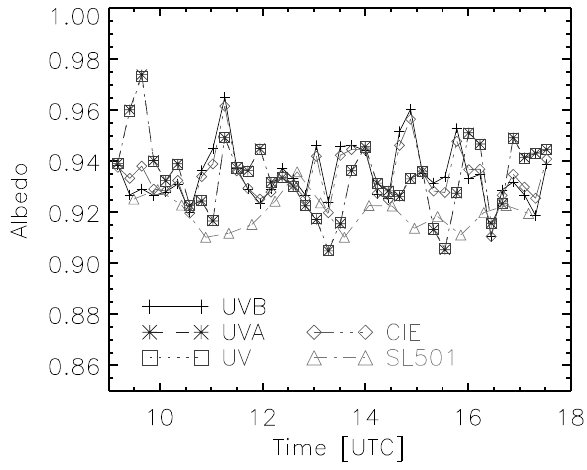
Fig. 9. Ratios of modelled snow albedo (A) for different solar zenith angles. In both cases the ratio is between 0.96 and 1.0 for all wavelengths. Thus, the albedo is larger at larger SZA compared to smaller SZA. The local minima at 320, 385, and 650nm are due to Mie scattering processes for single snow grain size